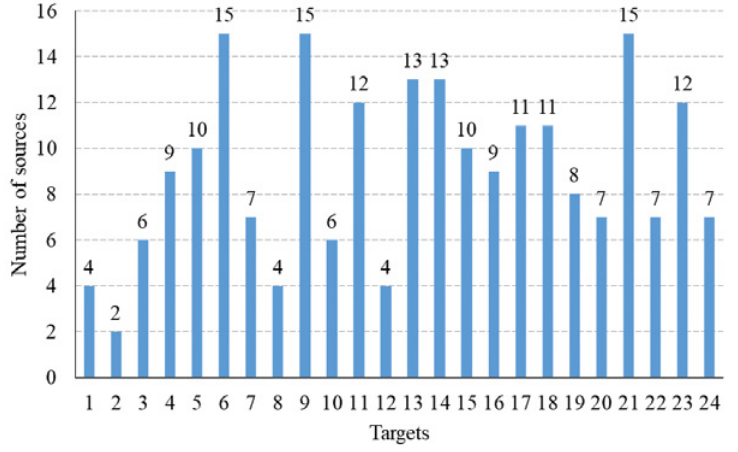
Figure 1. The number of sources repeated in